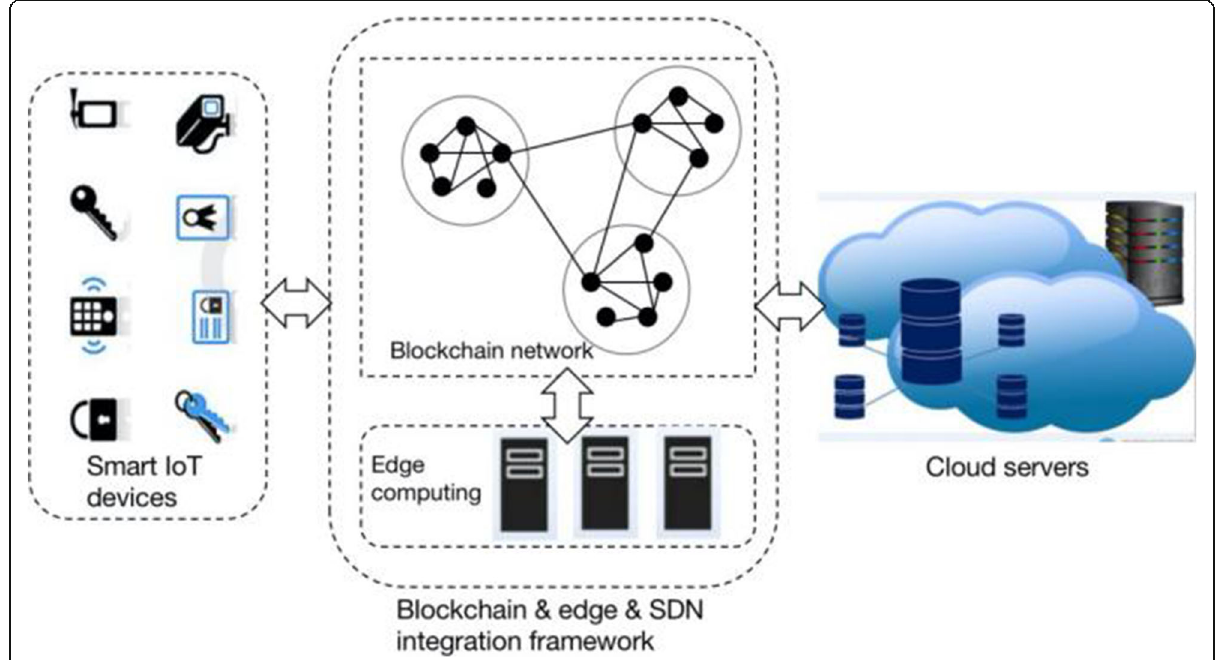
Fig. 14 Blockchain-enabled cloud-edge-SDN integration security framework [83]